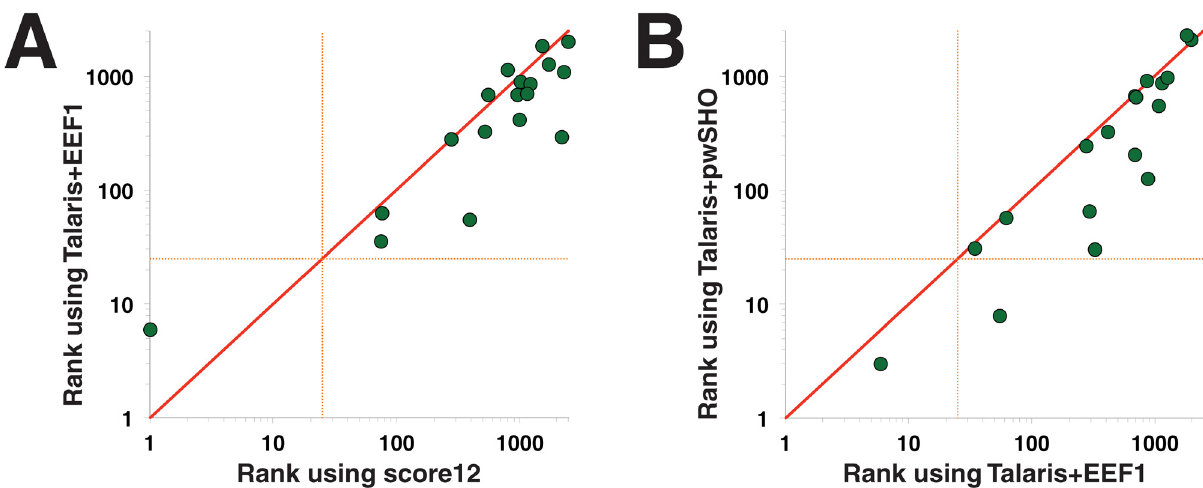
Fig 3. Recent enhancements to the functional form of the Rosetta energy function enable improved performance. (A) Rosetta ’ s “ Talaris ” energy function [19, 20, 30] includes updates to the functional form of the hydrogen bond term and of the electrostatic term. These changes lead to improved performance relative to score12, at a statistically significant level (p = 0.013). (B) Replacing Rosetta ’ s default model of polar solvation, EEF1, with a newly developed model, pwSHO [31], leads to further improvement at a statistically significant level (p =